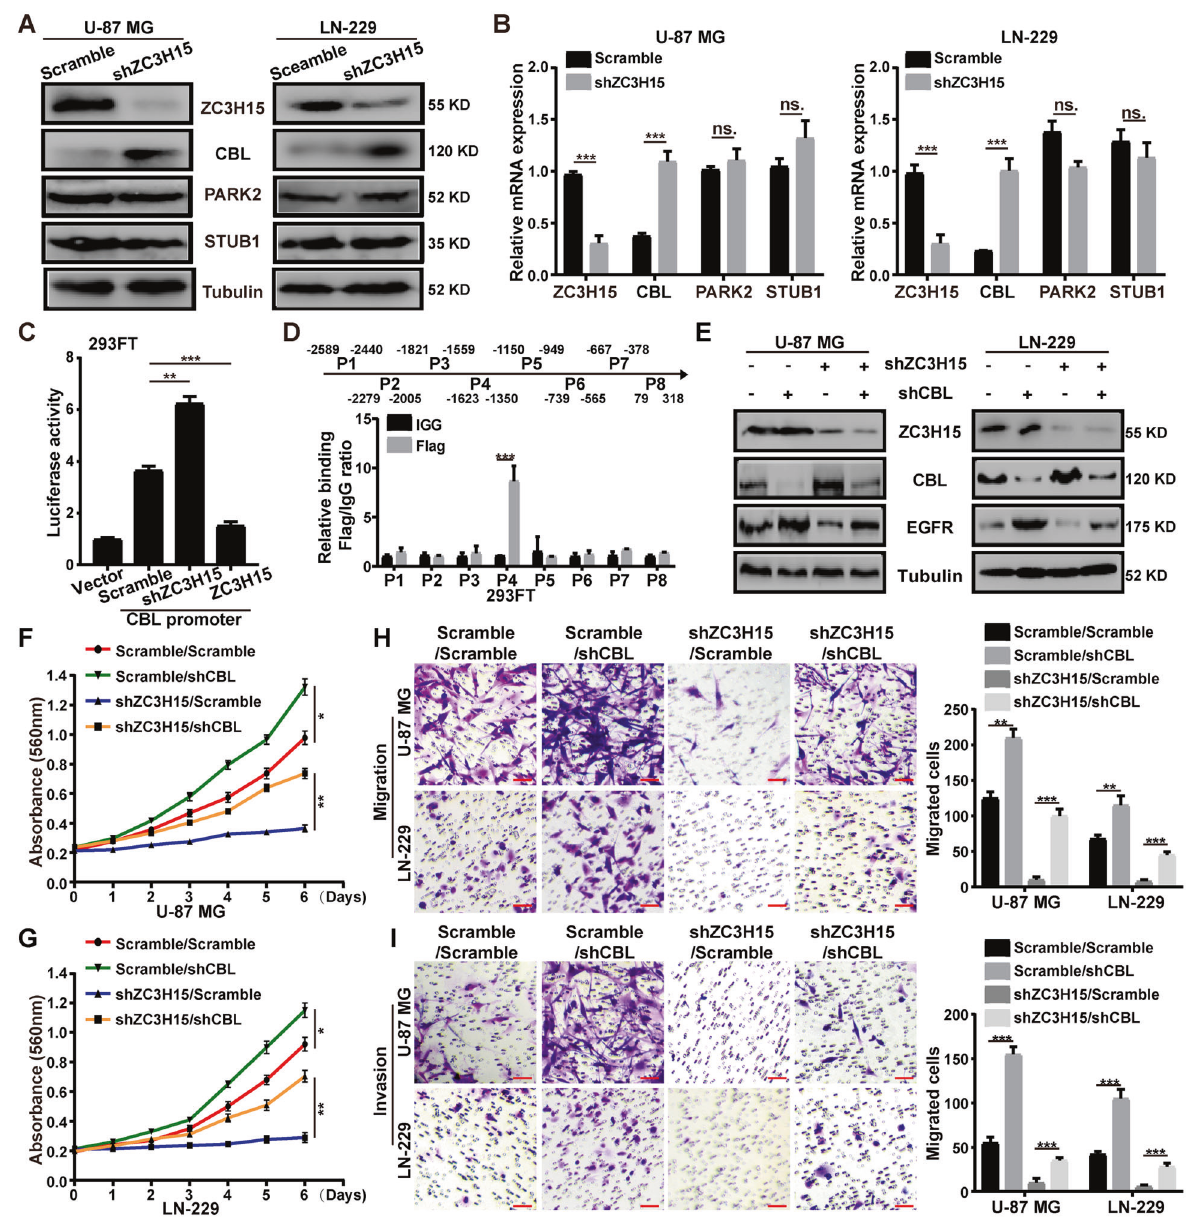
Fig. 5 ZC3H15 suppressed the transcription of E3 ligase CBL. A , B The protein level and mRNA level of several E3 ubiquitin ligases were detected in ZC3H15 knockdown and control cells. C The transcriptional activity of CBL in control and ZC3H15 knockdown and overexpression group were detected. D ChIP assay was performed by using Flag antibodies. IgG was used as the negative control. E The protein levels of ZC3H15, CBL, and EGFR were detected by western blot analysis. F , G The recovery of cellular proliferation was detected in ZC3H15-knockdown cells followed by CBL knockdown. H , I The recovery of the migration and invasion abilities in ZC3H15-knockdown cells followed by CBL knockdown. All data were expressed as mean ± SD. Student ’ s t test was performed to analyzed signi fi cance. * P < 0.05, ** P < 0.01, *** P <